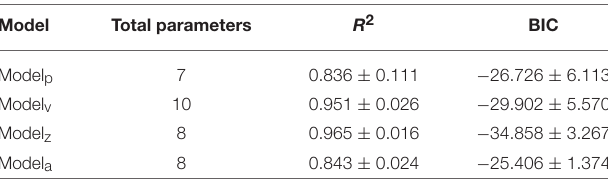
TABLE 5 | Model performance comparison via BIC and R 2 metrics (mean ± sd across